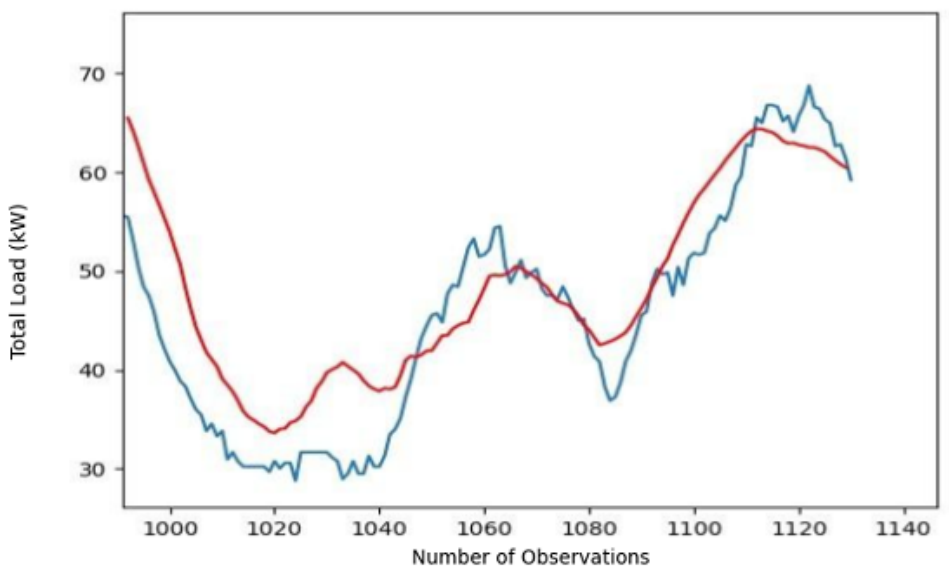
Figure 11. Actual and forecasted load (Trento). The actual load is depicted with red color and the forecasted time series with blue